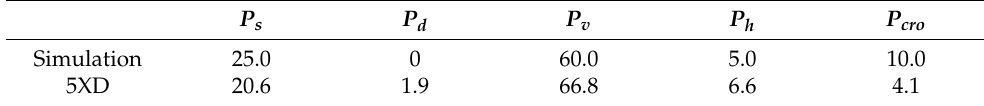
Table 4. The results of simulation data for 5XD (%).